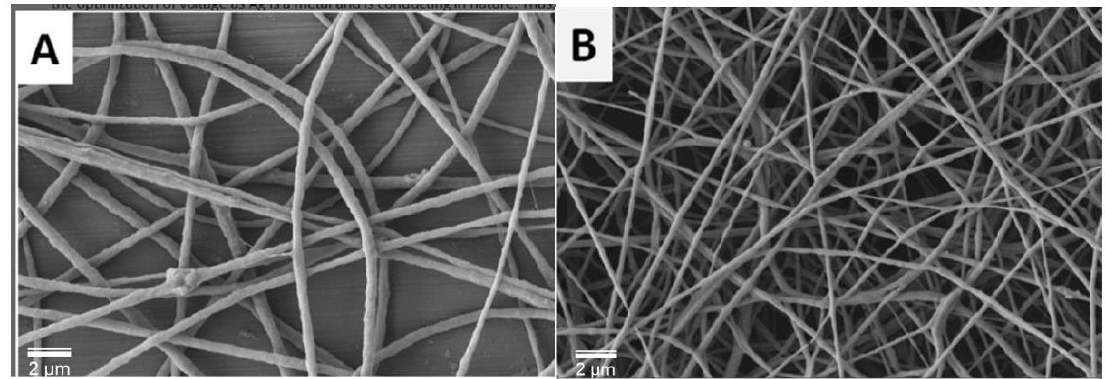
Figure 4. SEM images of ( A ) poly(ethylene oxide) (PEO)–PCL-blended nanofiber and ( B ) PEO-PCL/Ag NPs composite nanofibers (adapted with permission from reference [17]).